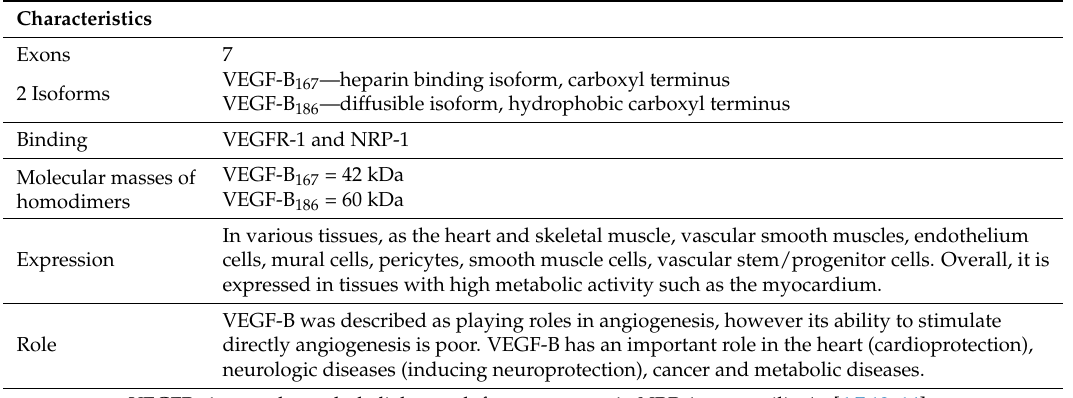
Table 1. Summary of the characteristics of Vascular endothelial growth factor B